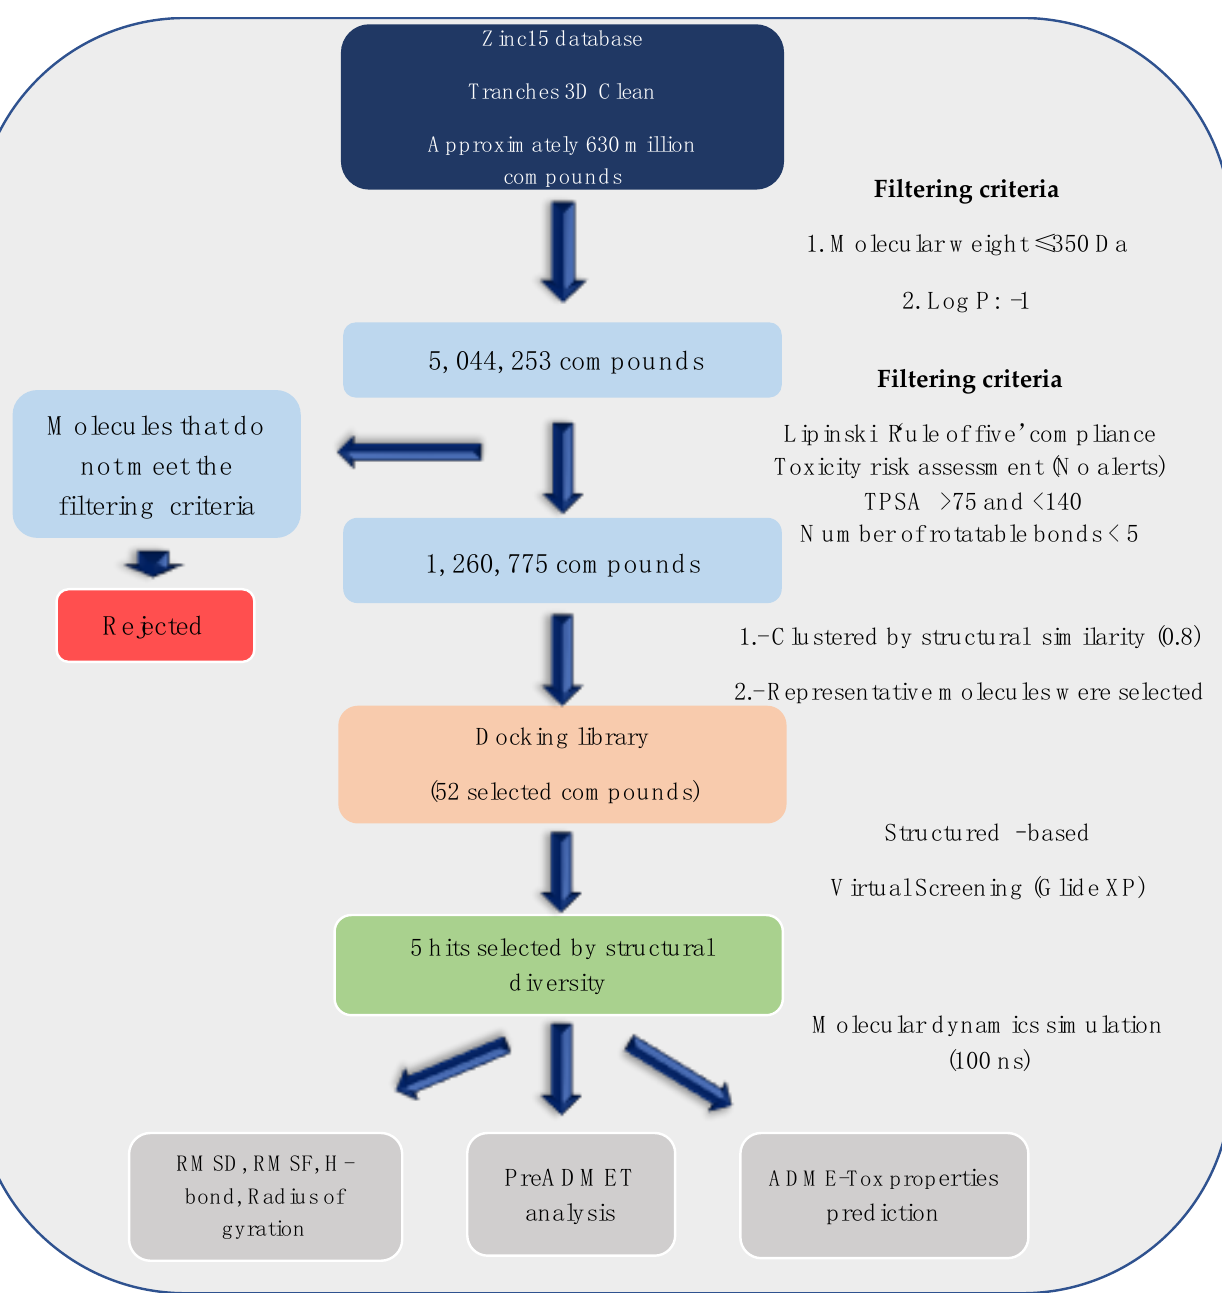
Table 1. Glide XP docking results for the top five hits. 102